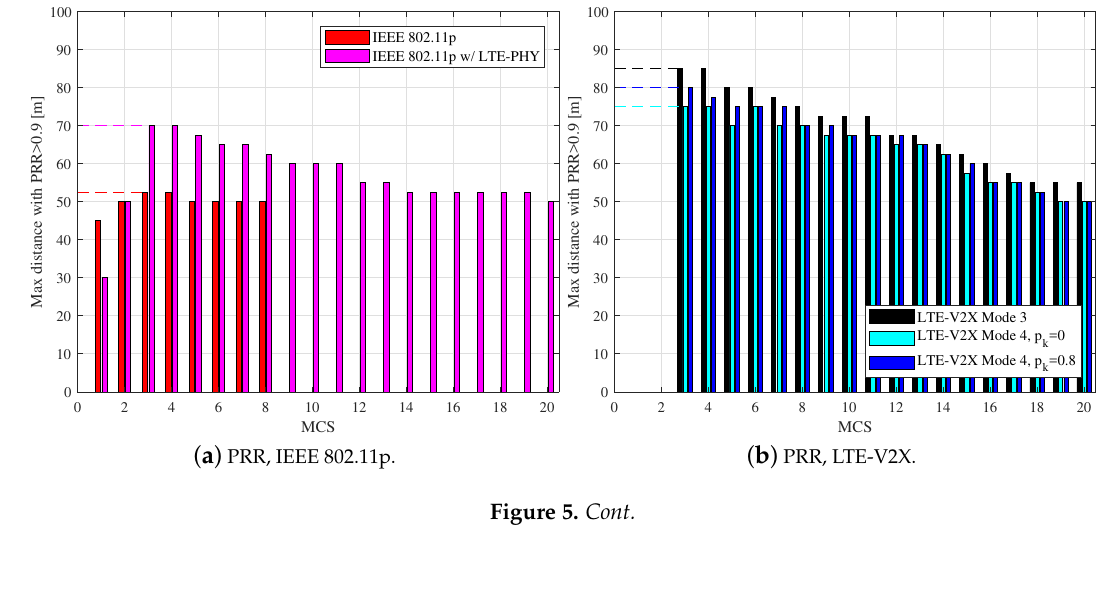
Figure 4. Packet reception ratio and update delay in Bologna.